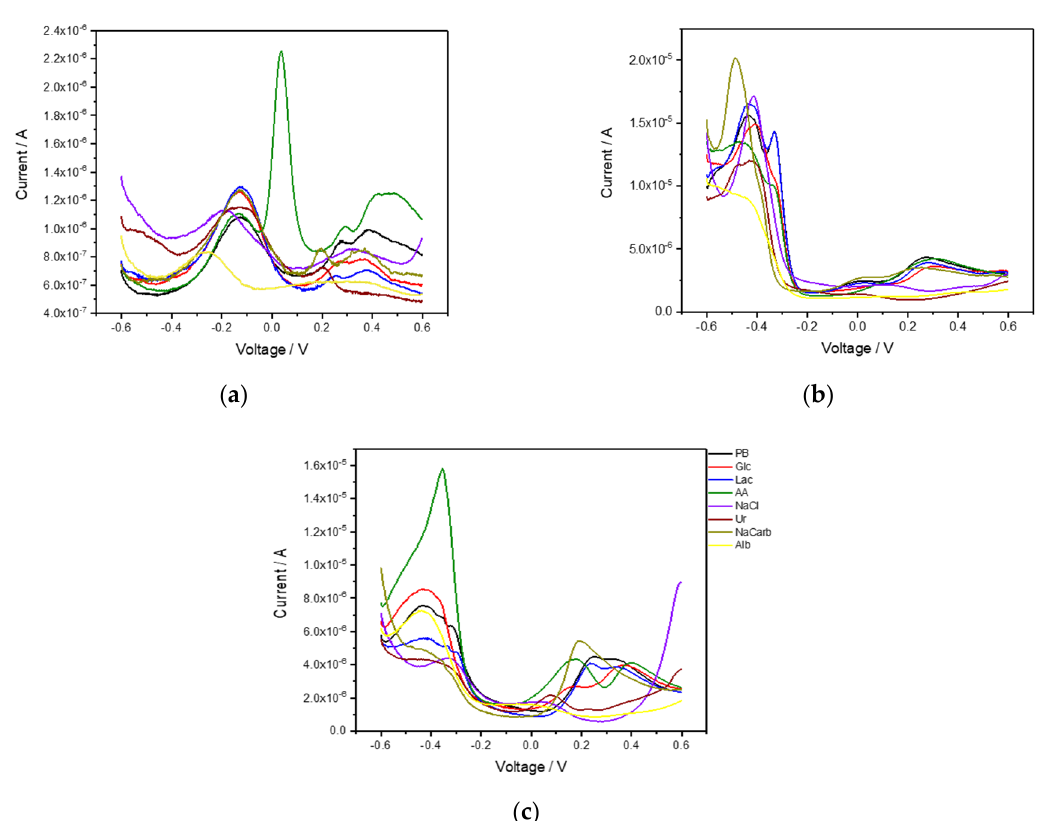
Figure 1. Differential pulse voltammetry (scan rate 20 mV/s, pulse amplitude 25 mV, pulse time 50 ms) of ( a ) gold, ( b ) platinum and ( c ) palladium electrodes in PB and PB spiked with 5 mM glucose (Glc), 10 mM lactate (Lac), 100 µ g mL − 1 ascorbic acid (AA), 150 mM sodium chloride, 10 mM urea (Ur), 100 mM sodium bicarbonate (NaCarb) or 10 mg mL − 1 albumin